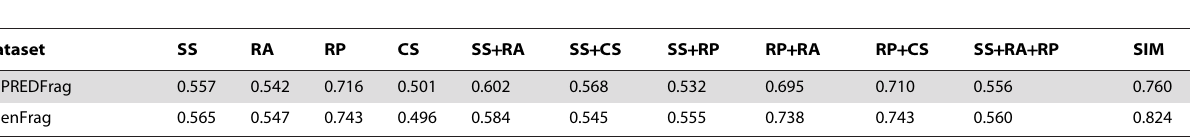
Table 4. AUC values on the BCPREDFrag and ChenFrag datasets calculated using 10-fold cross validation obtained by using selected features from individual feature groups; abbreviates names of feature groups are given in Table 1.